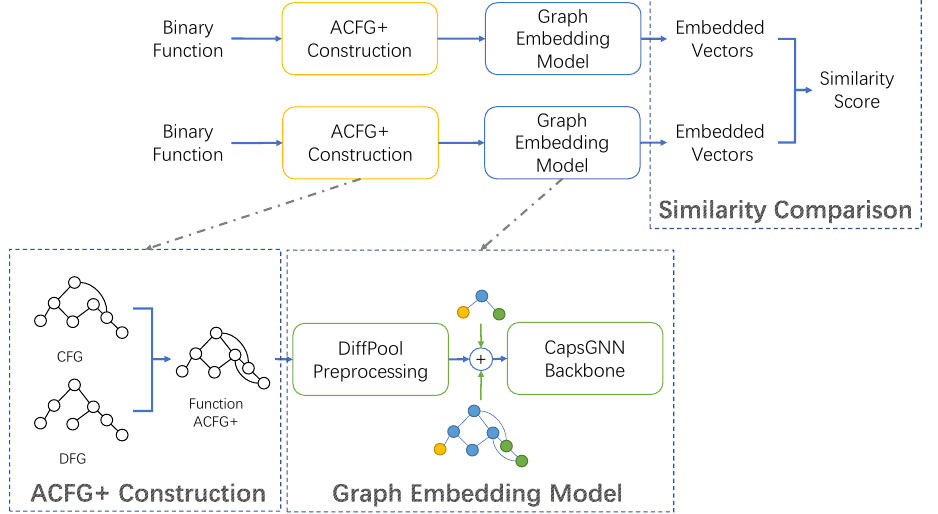
Figure 2. Overview.